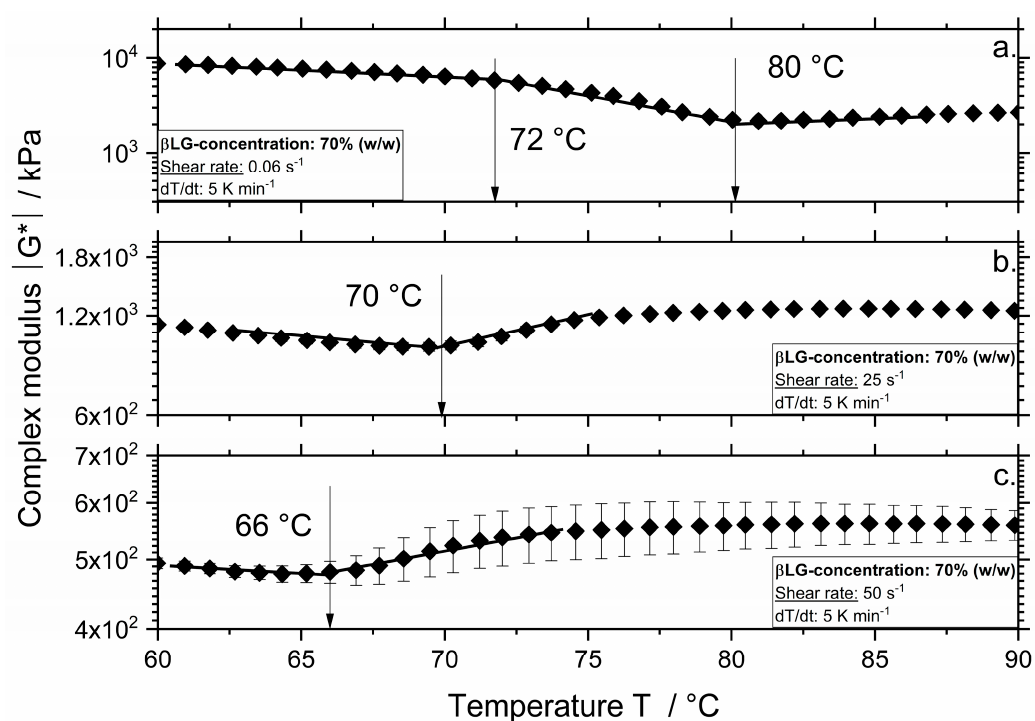
Figure 2. Complex modulus | G ∗ | as a function of the temperature for systems with a β LG concentration of 70% ( w / w ) and a shear rate of 0.06 ( a ), 25 ( b ), and 50 s − 1 ( c ). Measurements were performed at a constant heating rate of 5 K min − 1 .